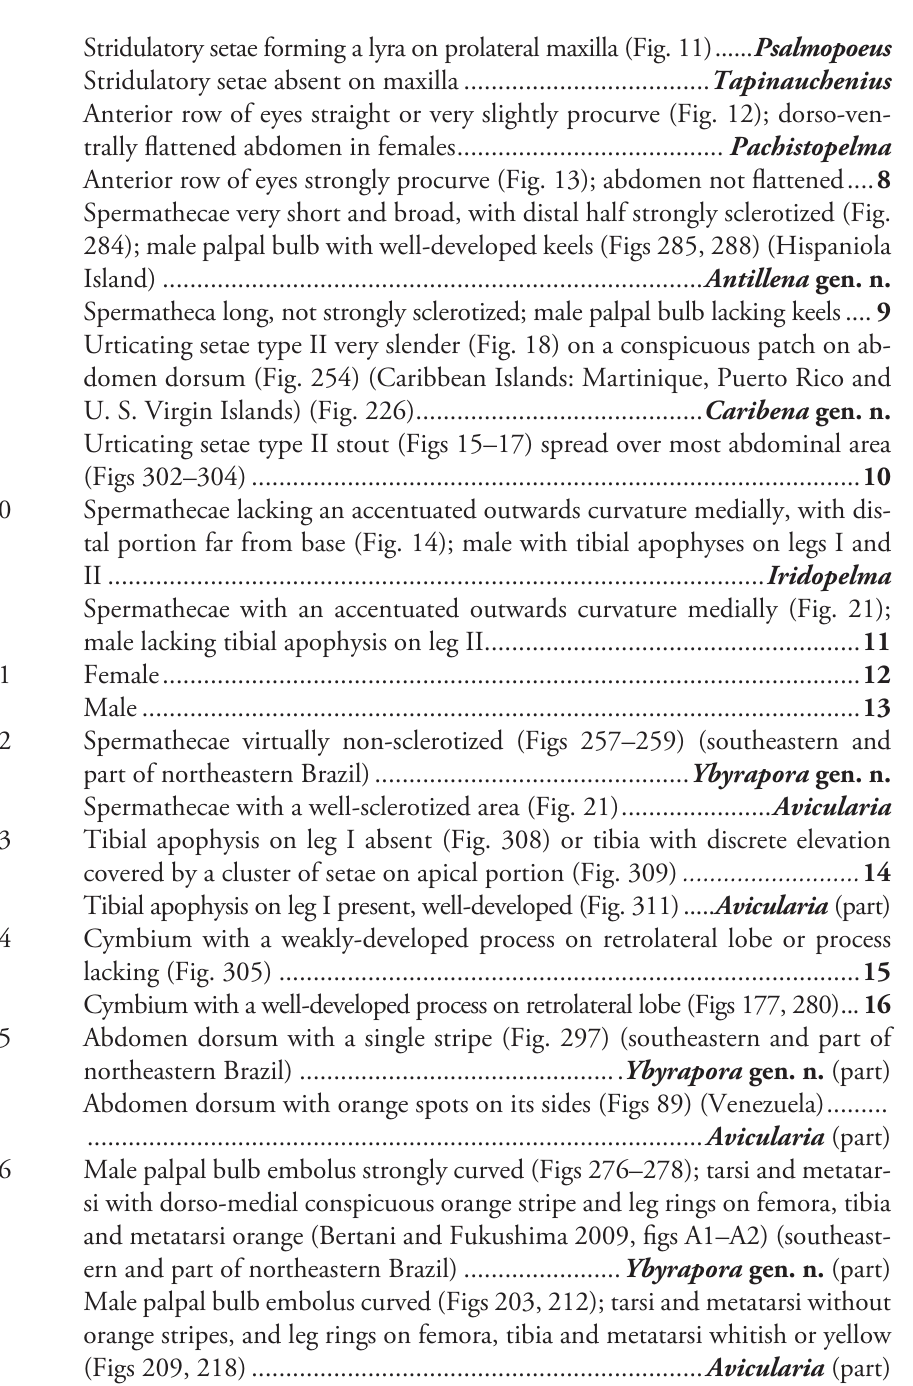
– Anterior row of eyes straight or very slightly procurve (Fig. 12); dorso-ven- – Anterior row of eyes strongly procurve (Fig. 13); abdomen not flattened .... 8 8 Spermathecae very short and broad, with distal half strongly sclerotized (Fig. 284); male palpal bulb with well-developed keels (Figs 285, 288) (Hispaniola – Spermatheca long, not strongly sclerotized; male palpal bulb lacking keels .... 9 9 Urticating setae type II very slender (Fig. 18) on a conspicuous patch on ab- domen dorsum (Fig. 254) (Caribbean Islands: Martinique, Puerto Rico and U. S. Virgin Islands) (Fig. 226) .......................................... Caribena gen. n. – Urticating setae type II stout (Figs 15–17) spread over most abdominal area (Figs 302–304) ......................................................................................... 10 10 Spermathecae lacking an accentuated outwards curvature medially, with dis- tal portion far from base (Fig. 14); male with tibial apophyses on legs I and – Spermathecae with an accentuated outwards curvature medially (Fig. 21); male lacking tibial apophysis on leg II ....................................................... 11 11 – 12 Spermathecae virtually non-sclerotized (Figs 257–259) (southeastern and part of northeastern Brazil) .............................................. Ybyrapora gen. n. – Spermathecae with a well-sclerotized area (Fig. 21) ...................... Avicularia 13 Tibial apophysis on leg I absent (Fig. 308) or tibia with discrete elevation covered by a cluster of setae on apical portion (Fig. 309) .......................... 14 – Tibial apophysis on leg I present, well-developed (Fig. 311) ..... Avicularia (part) 14 Cymbium with a weakly-developed process on retrolateral lobe or process – Cymbium with a well-developed process on retrolateral lobe (Figs 177, 280) ... 16 15 Abdomen dorsum with a single stripe (Fig. 297) (southeastern and part of northeastern Brazil) ............................................... Ybyrapora gen. n. (part) – Abdomen dorsum with orange spots on its sides (Figs 89) (Venezuela) ......... 16 Male palpal bulb embolus strongly curved (Figs 276–278); tarsi and metatar- si with dorso-medial conspicuous orange stripe and leg rings on femora, tibia and metatarsi orange (Bertani and Fukushima 2009, figs A1–A2) (southeast- – Male palpal bulb embolus curved (Figs 203, 212); tarsi and metatarsi without orange stripes, and leg rings on femora, tibia and metatarsi whitish or